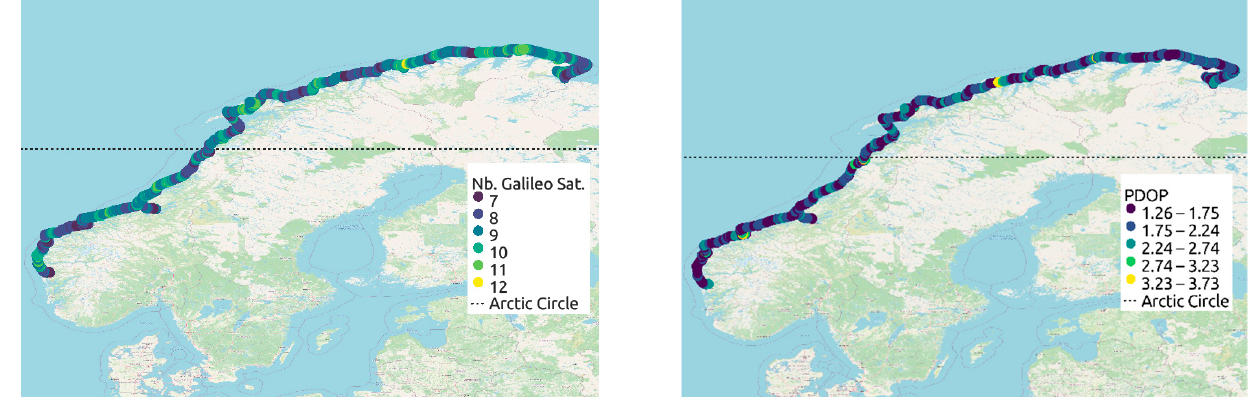
Figure 4. Vessel trajectory color coded as a function of the number of satellites ( left ) and PDOP ( right ) based on Galileo satellite constellation.